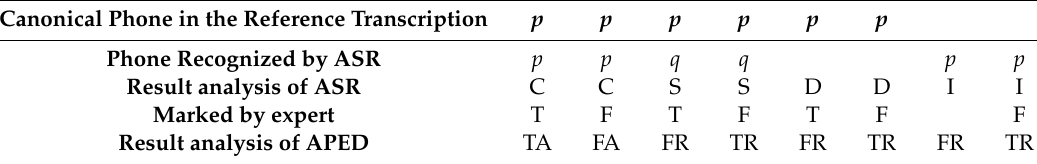
Table 5. A result analysis of APED Based on